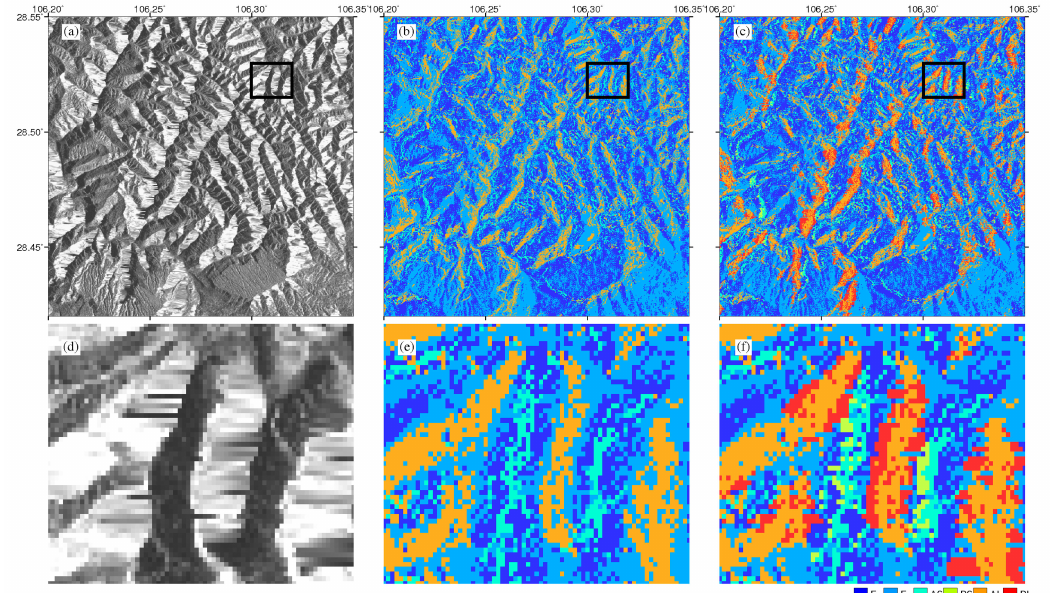
Figure 5. Geometric distortions in the ALOS descending image. ( a , d ) display the intensity image; ( b , e ) display the SDG map derived by the F-ALS method; ( c , f ) display the SDG map derived by the P-NG method. E: Resolution-Enhancing; F: Foreshortening; AS: Active Shadow; PS: Passive Shadow; AL: Active Layover; PL: Passive